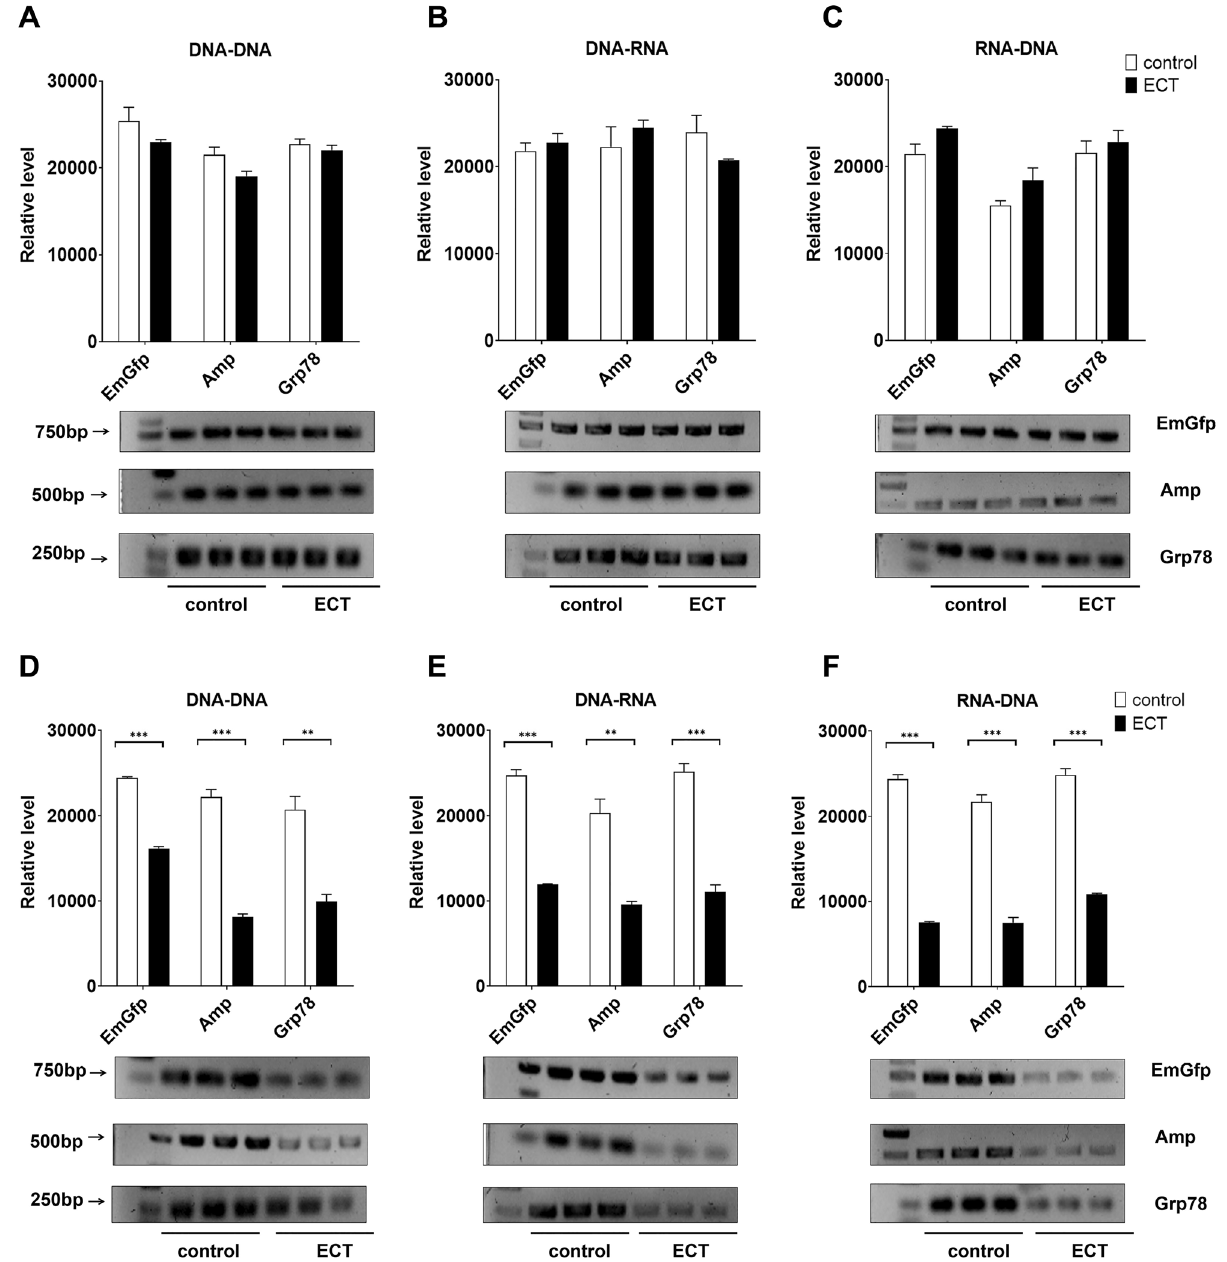
Figure 7. After lysozyme ECT gavage, rabbit gastric juice and jejunum fluid showed different effects on EmGfp, Amp and Grp78 DNA replication, transcription and reverse transcription in vitro. ( A )–( I ) Gel electrophoresis of PCR products. Lavage fluid of the gastric juice ( A )–( C ) and the upper ( D )–( F ) and lower ( G )–( I ) jejunum were added to the reaction system: ( A / D / G ) replication, ( B / E / H ) transcription and ( C / F / I ) reverse transcription. Intensity analysis of target bands in gel electrophoresis is shown at the top of the blot. Data are representative of 2 independent experiments and presented as the mean ± SD; * p < 0.05, *** p < 0.001. Significant differences were evaluated using one-way ANOVA with a post hoc test (Fisher’s least significant